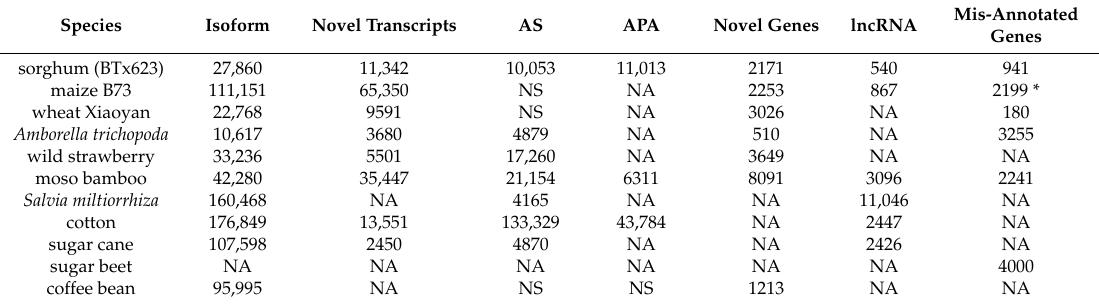
Table 3. Plant genome annotation by using